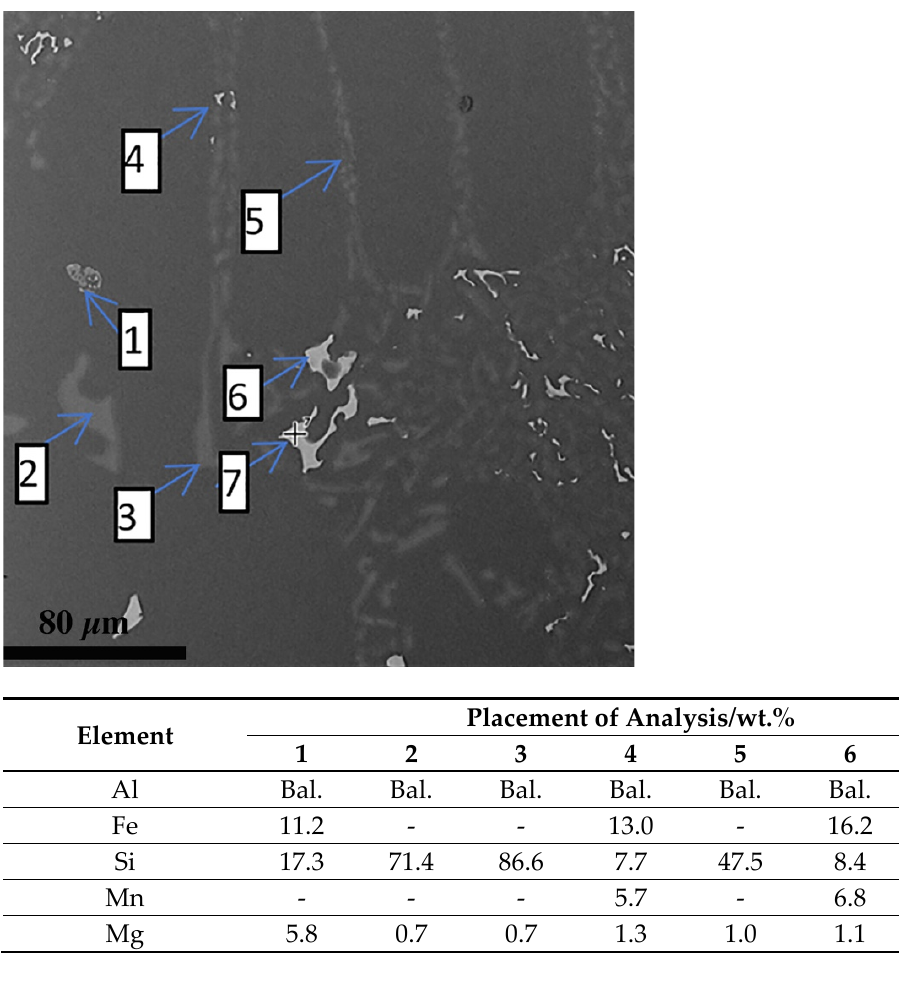
Figure 10. Microstructure of cast samples before and after heat treatment (SEM): ( A ) after casting, ( B ) after supersaturation, ( C ) after supersaturation and ageing—2 h, ( D ) after supersaturation and ageing—4 h, ( E ) after supersaturation and ageing—6 h, ( F ) after supersaturation and ageing—8 h and ( G ) after supersaturation and ageing—16 h.